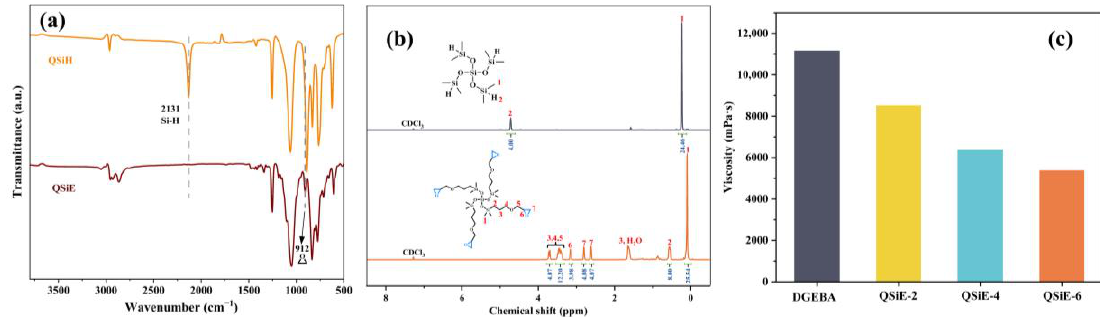
Figure 1. The FTIR spectra ( a ) and 1 H NMR spectra ( b ) of QSiH and QSiE, ( c ) Viscosity-reduction effect of QSiE.